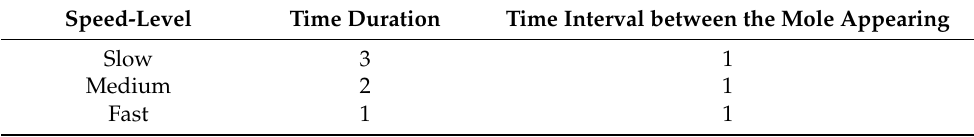
Table 1. Time difference based on the speed level of the whack-a-mole game (in seconds).